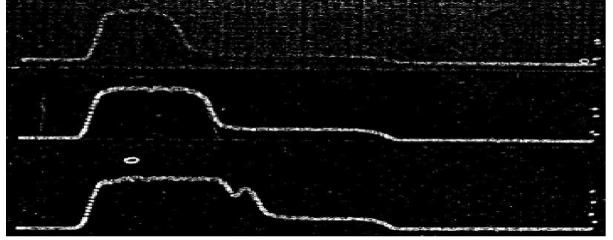
FIG. 9. Longitudinal Schottky